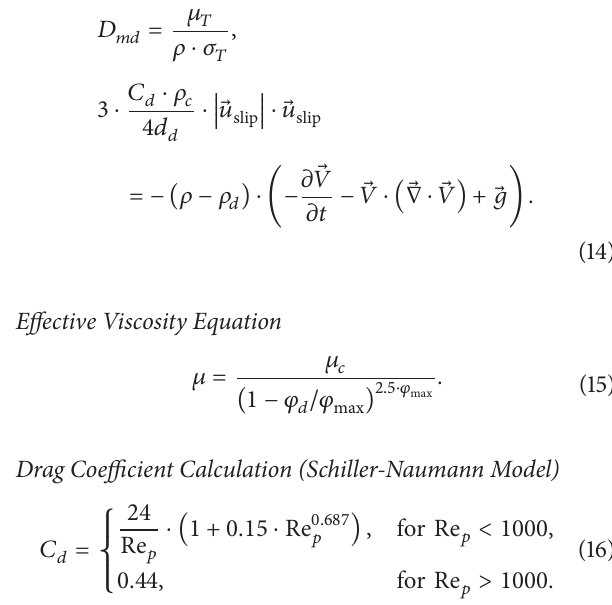
Figure 7: Physical